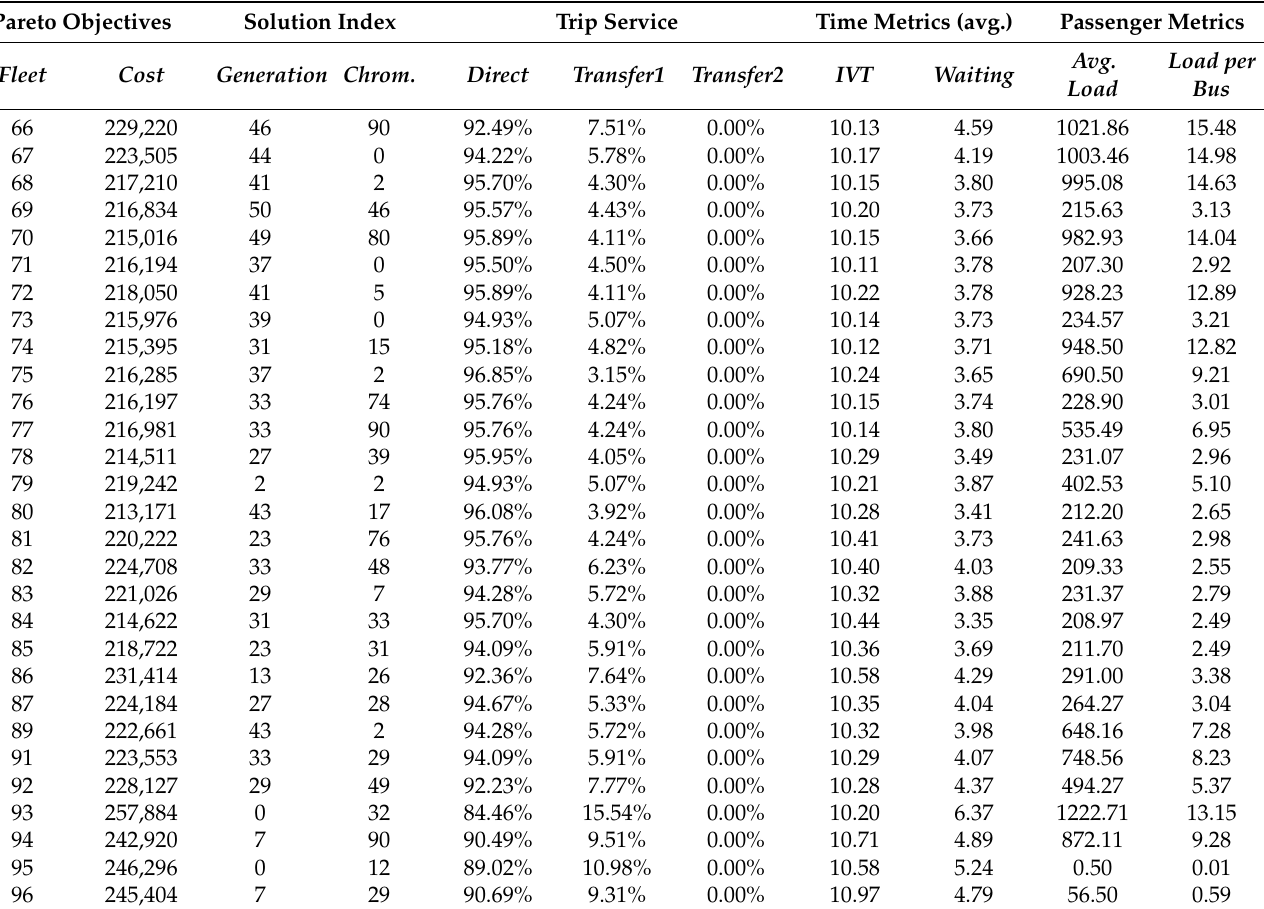
Table 3. Pareto Optimal